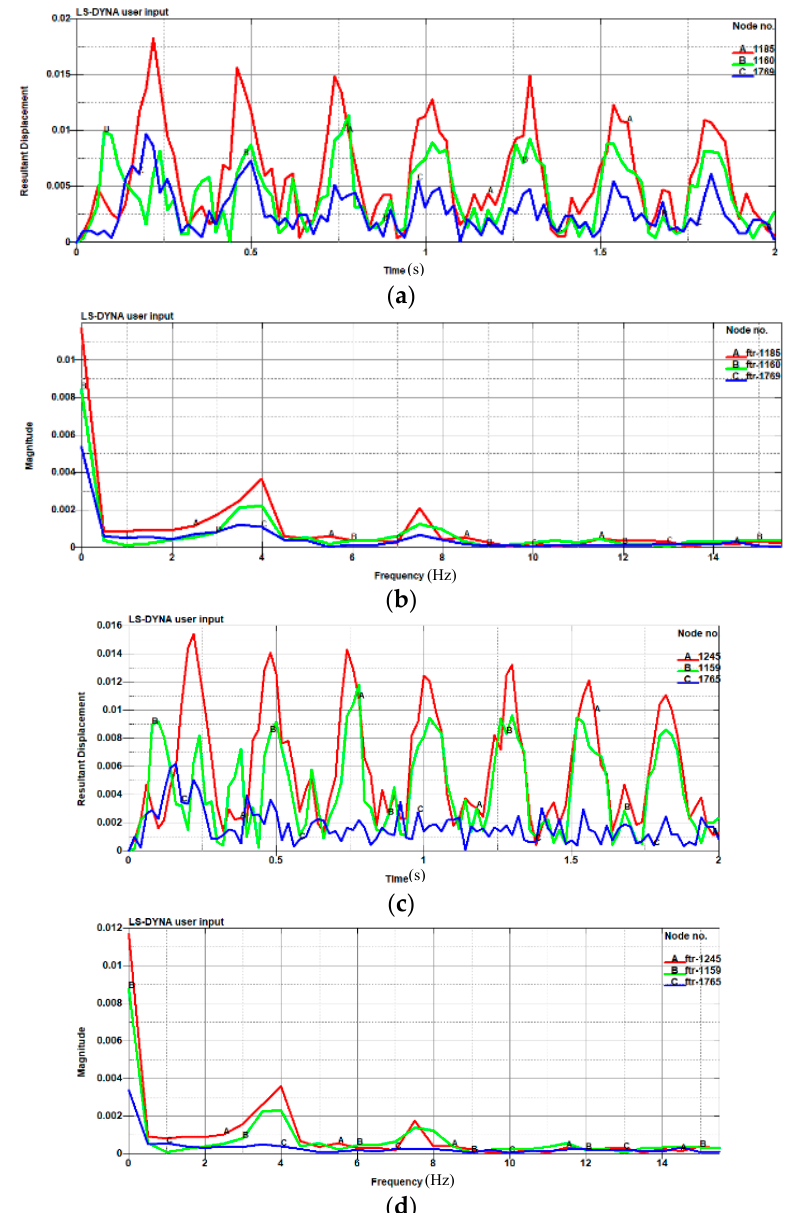
Figure 11. The displacement vs. time and correspondent result of FFT, P11, and P13. ( a ) The displacements of points at the condition P11. ( b ) The corresponding result of FFT at the condition P11. ( c ) The displacements of points at the condition P13. ( d ) The corresponding result of FFT at the condition P13.